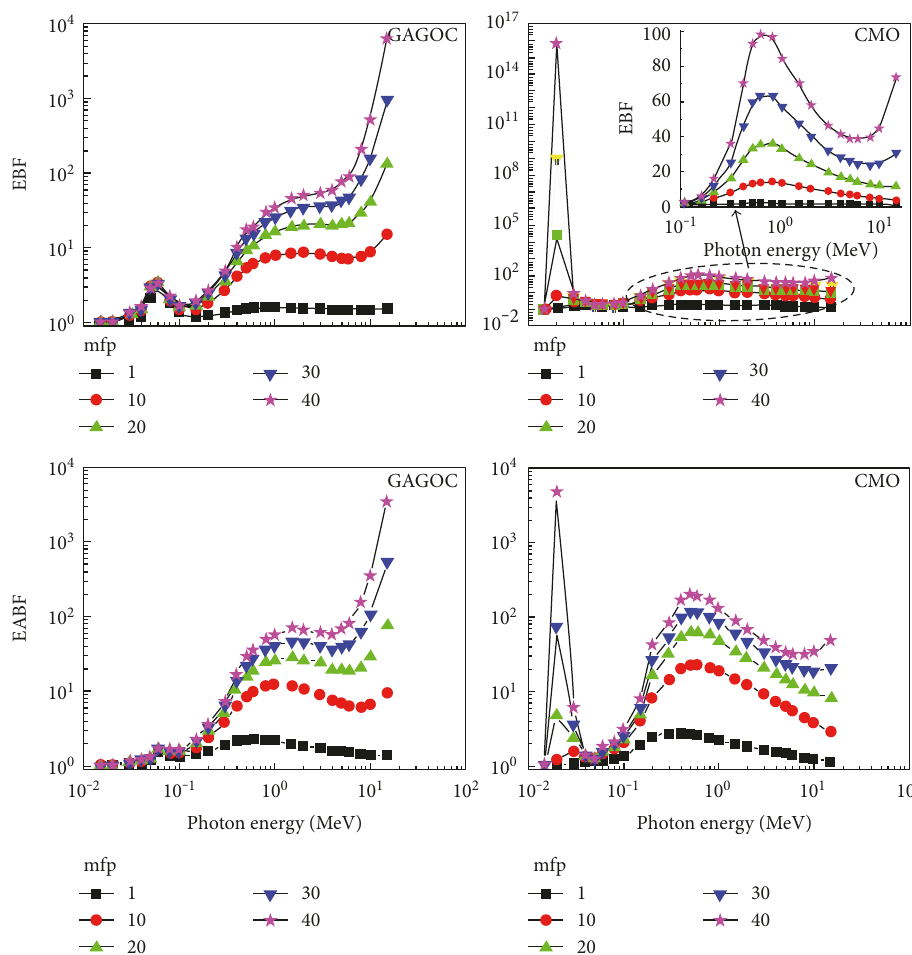
Figure 7: EBF and EABF variation for GAGOC and CMO with incident photon energy at 1, 10, 20, 30, and 40